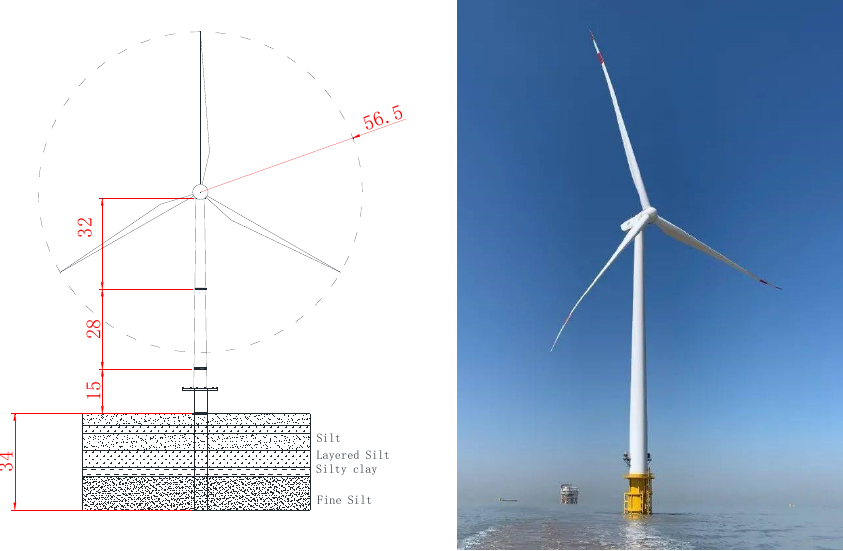
Figure 1. Structural dimensions and geological conditions of wind turbine tower.